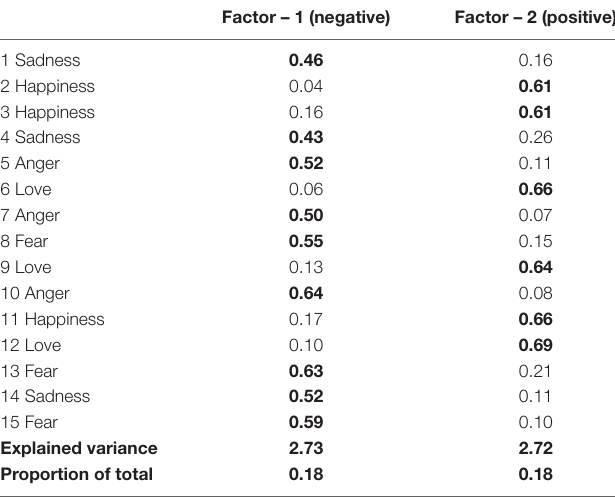
TABLE 3 | Factor loadings of the ECS items along two factors.